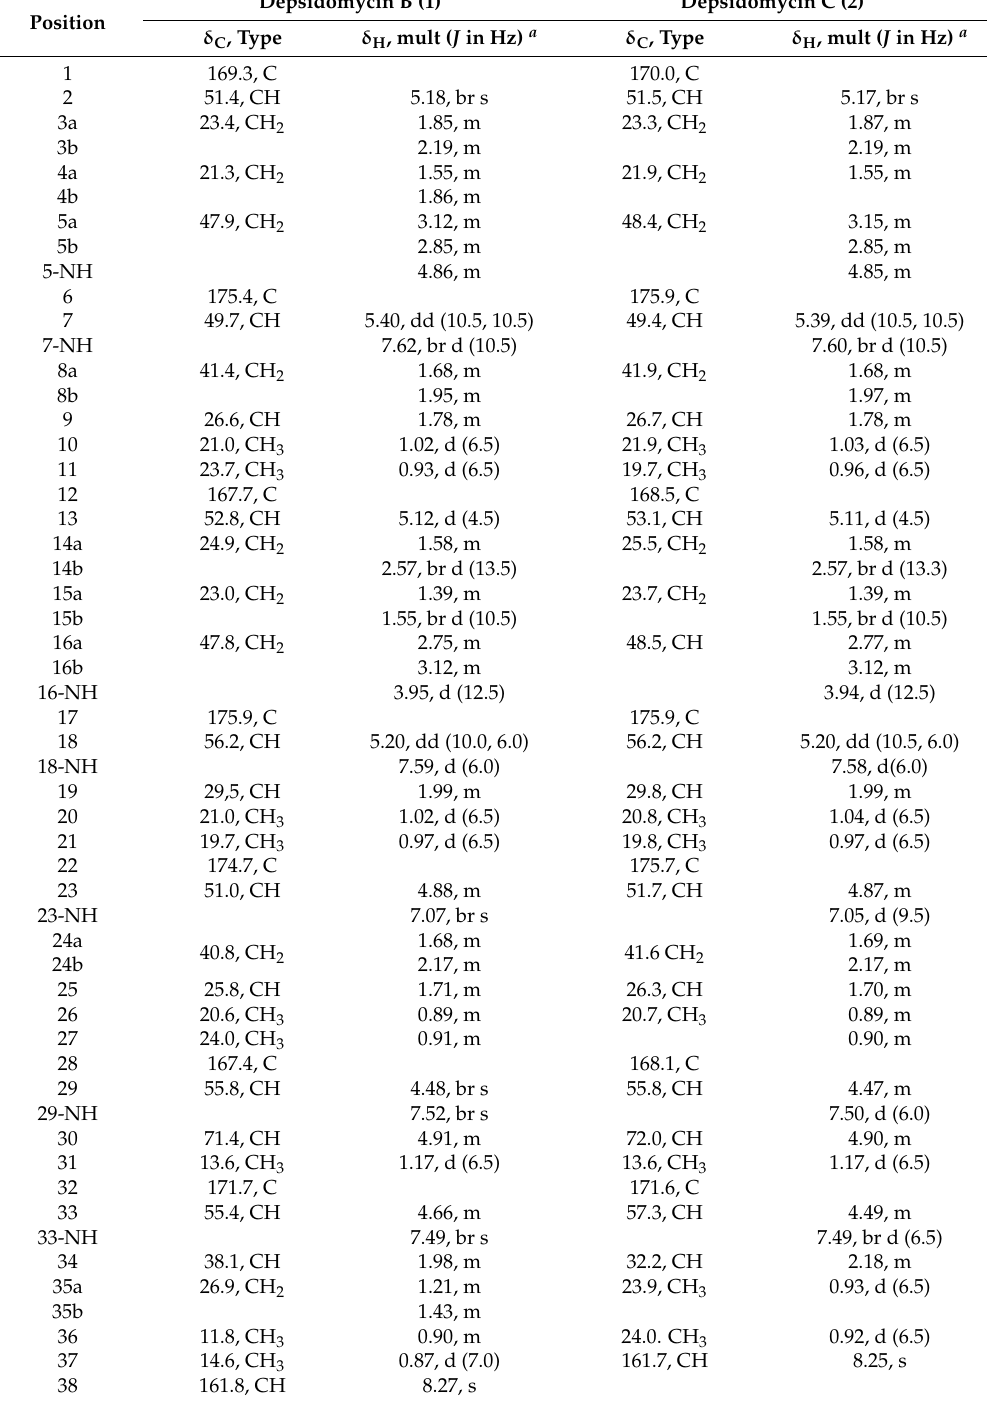
Table 1. 1 H and 13 C NMR data of depsidomycins B and C ( 1 and 2 ) in acetone- d 6 a